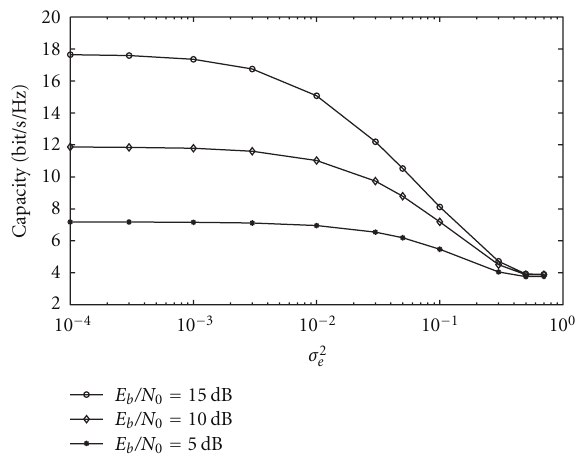
Figure 3: Impacts of CSI on the capacity performance of modified Turbo-BLAST systems with four transmit and four receive antennas in various values of E b /N 0